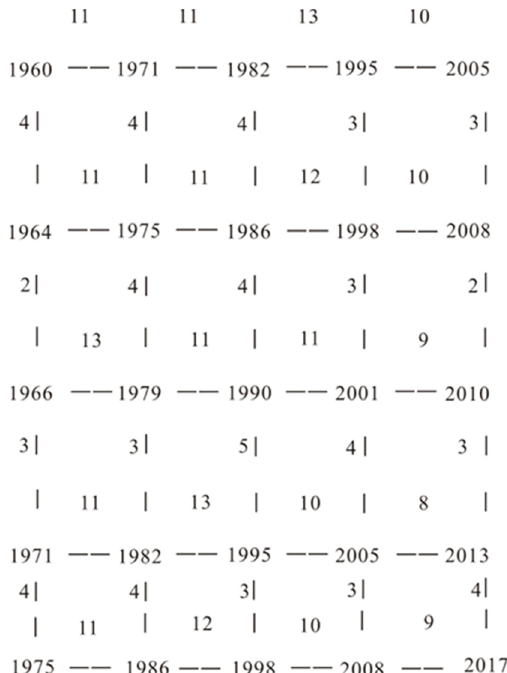
Figure 2. Commensurable network of annual main flood seasons (July to August) at the White Mountain